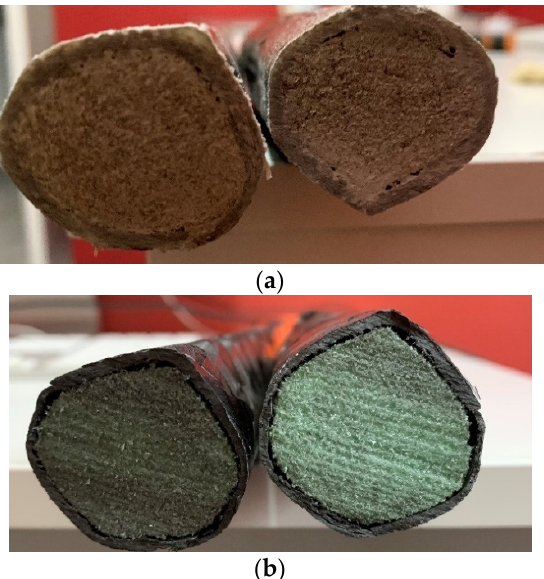
Figure 19. A cut into cross section of the fuselage ( a ) FQQ interface ( b ) HexMC fuselage .